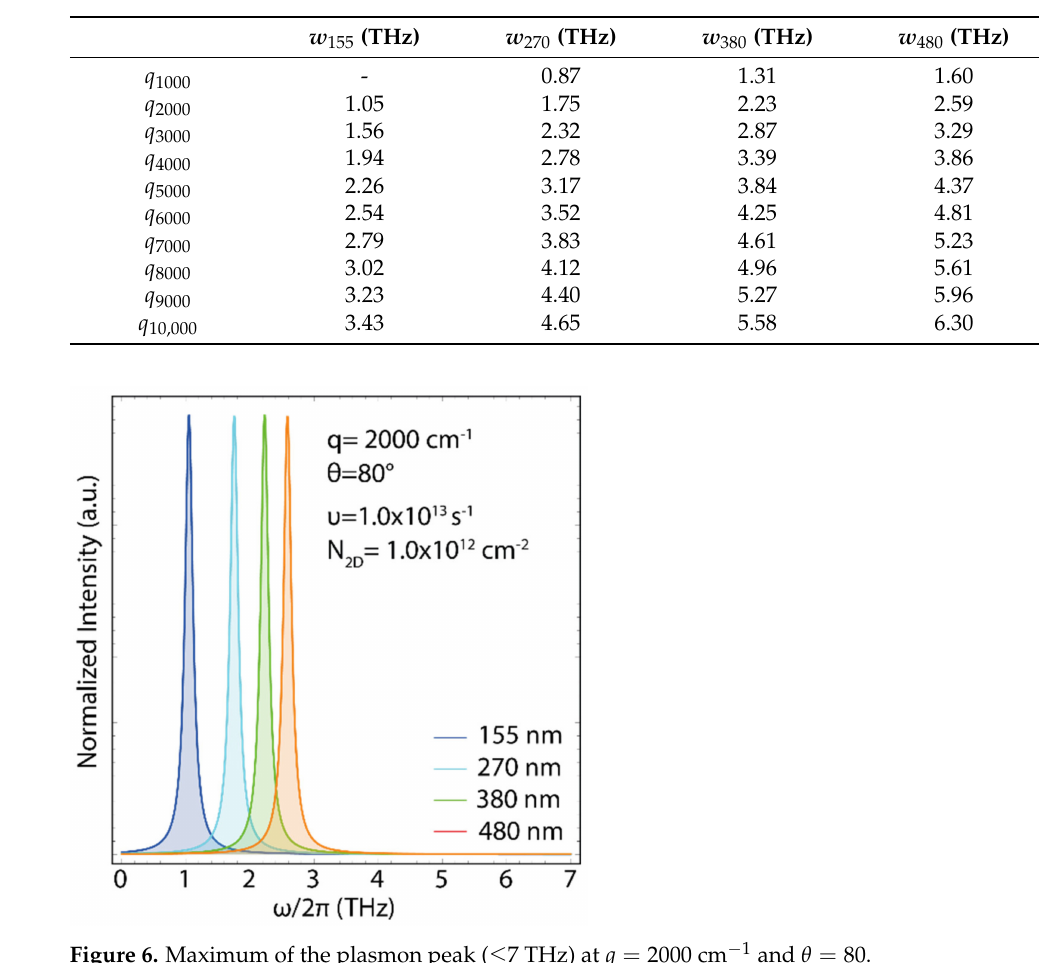
Table 4. Maximum of the plasmon peak for selected momenta at θ = 80.